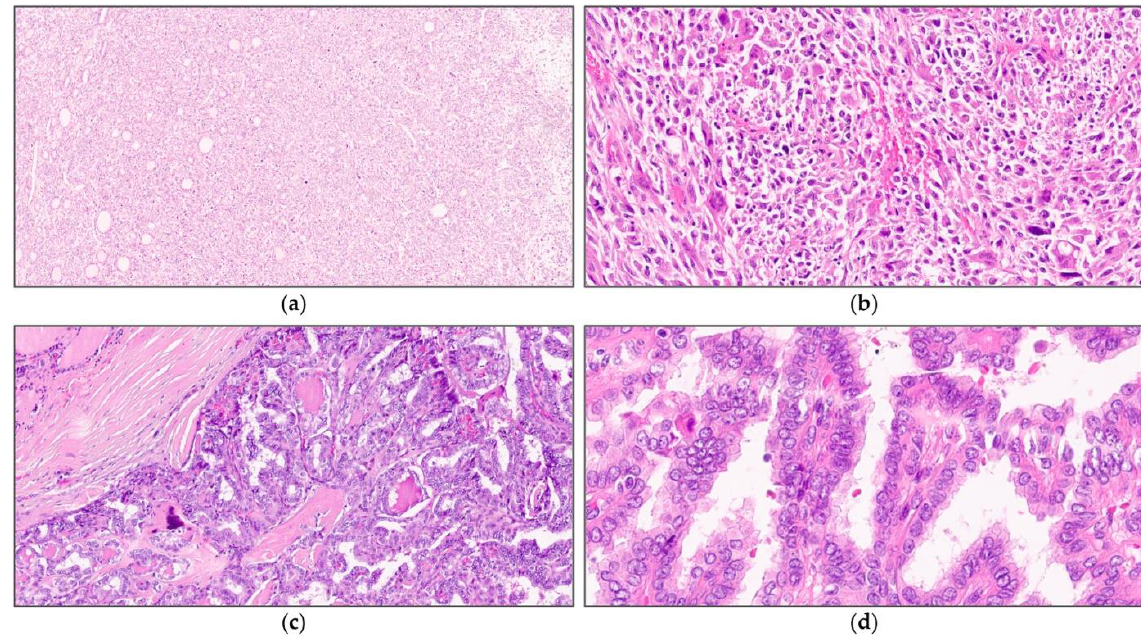
Figure 1. Representative images of thyroid cancers harboring a TERT promoter mutation ( a , b ) and a wild-type TERT promoter ( c , d ). Thyroid cancer with a TERT promoter mutation shows ( a ) a solid architecture with ( b ) prominent nuclear atypia and frequent mitosis, whereas that with a wild-type TERT promoter shows ( c ) conventional papillary architecture with ( d ) a lesser degree of nuclear atypia.